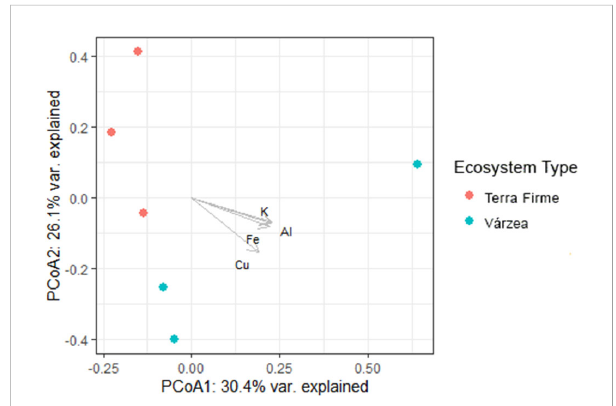
FIGURE 6 Principal Component Analysis (PCoA) correlating soil physical and chemical properties and mycobiome composition of the rhizosphere of Inga sp. seedlings collected at Tiputini Biodiversity Station in the Ecuadorian Amazon. Tropical forest ecosystems: red dots: terra fi rme, blue dots: va ́ rzea. The fi rst and second canonical axis explain together 56.5% of the variation. The vectors indicate soil chemical properties which explain the highest amount of variation: K: potassium, Al: aluminium, Fe: Iron, Cu: copper.